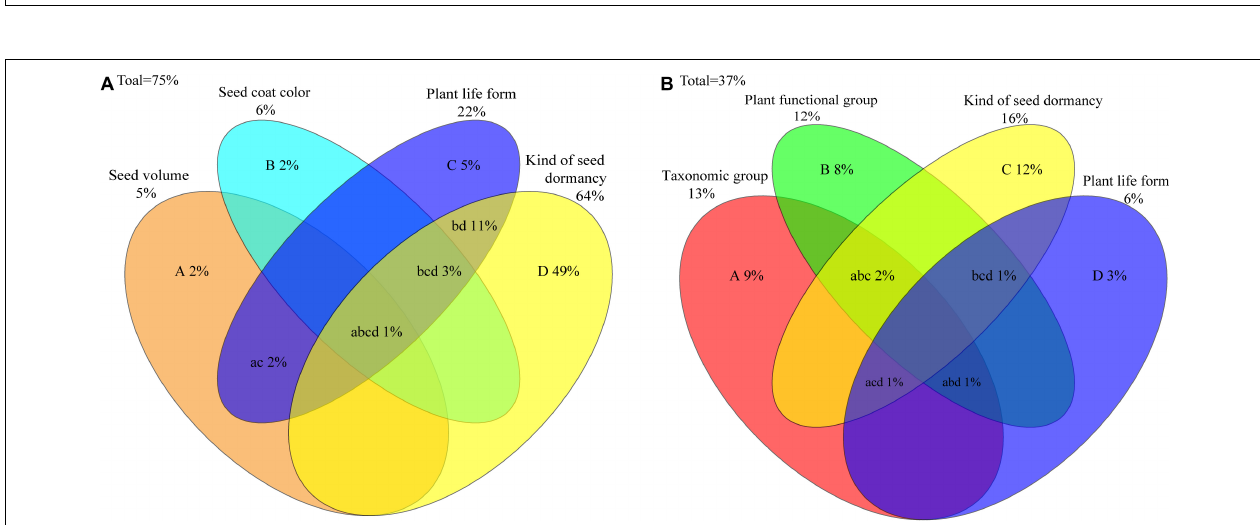
FIGURE 3 | Variation partitioning (%) of plant life form, seed volume, seed coat color, and seed dormancy type accounting for germination percentage (A) and taxonomic group, plant functional group, plant life form and kind of seed dormancy accounting for initial germination time of the studied species (B) . The uppercase letters denote the independent effects and the lowercase letters denote the joint effects of the overlapped two, three and four factors.